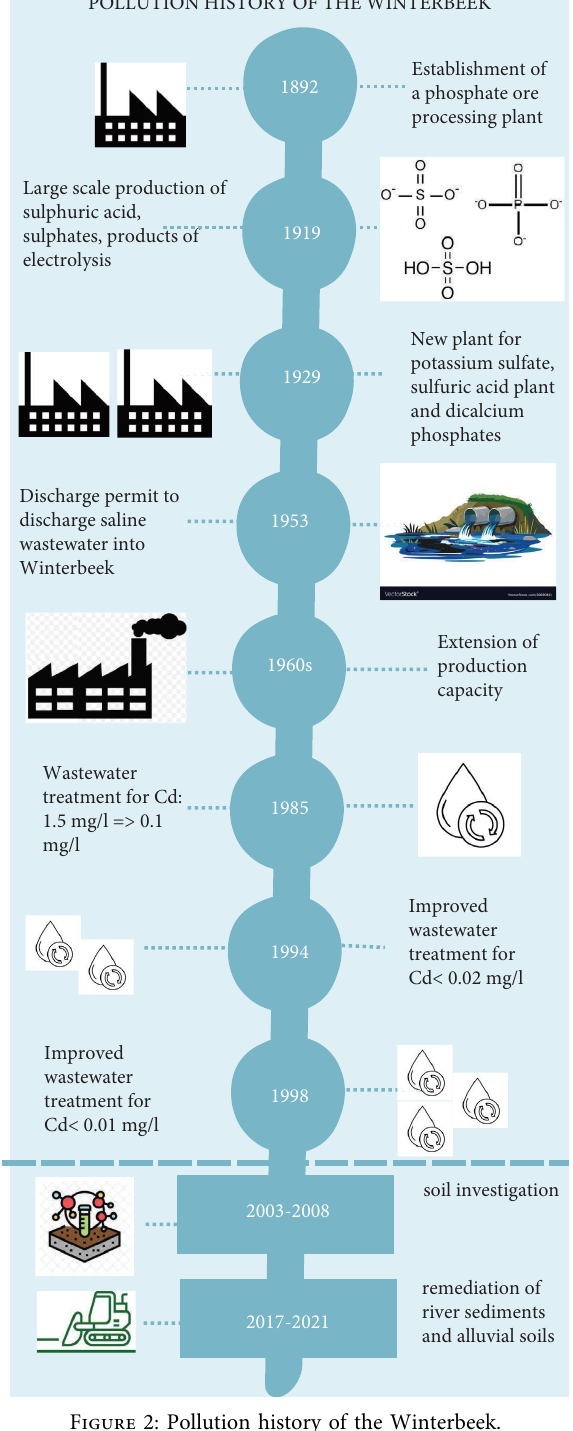
Figure 2: Pollution history of the